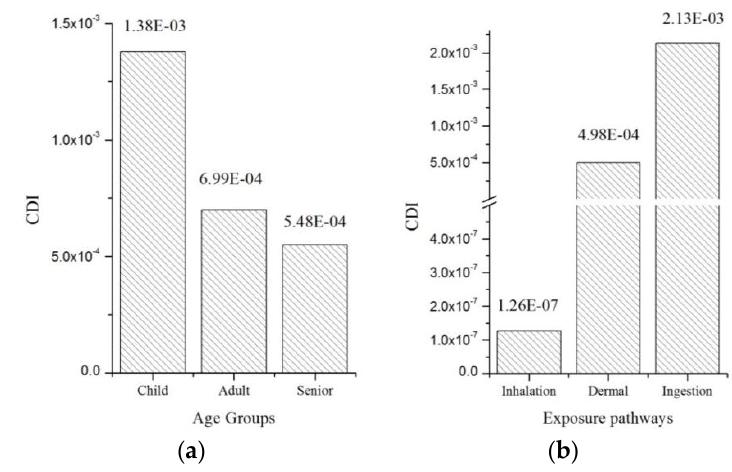
Figure 2. Total CDIs ( a ) and ( b ) of different exposure pathways in different age groups.